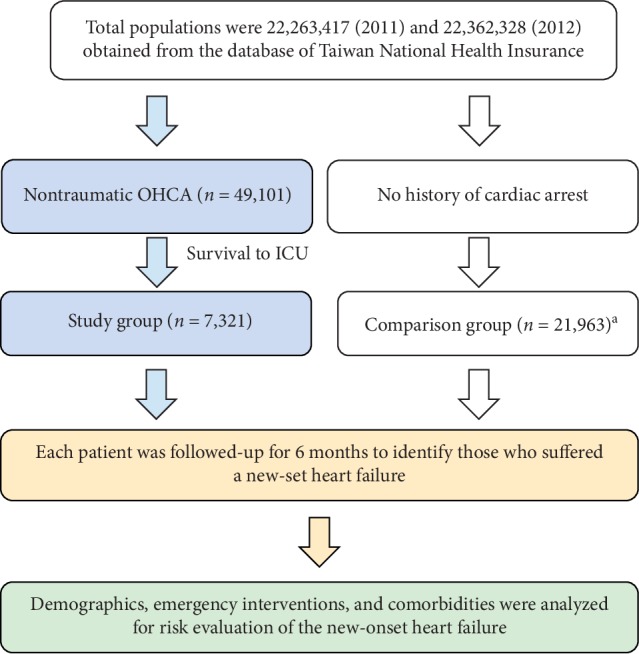
Selection flowchart of this study.